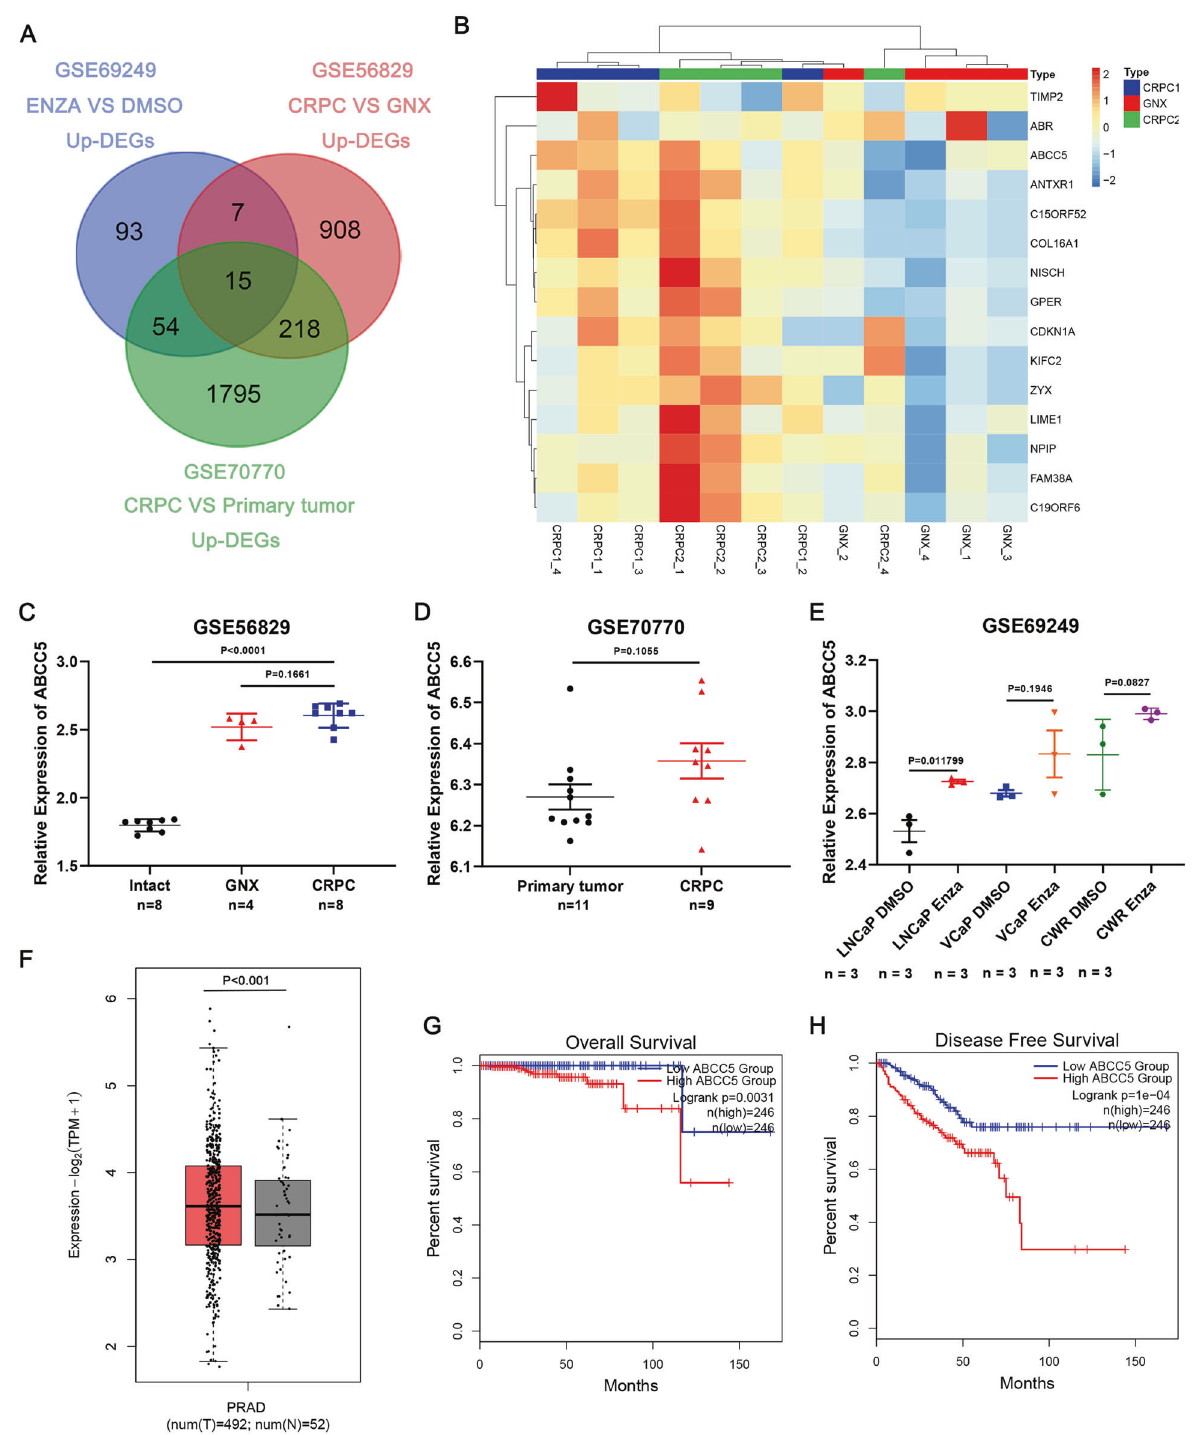
Fig. 1 ABCC5 expression is related to enzalutamide-resistance PCa and CRPC. A The Venn diagram gives the overlapped genes of high expression related to enzalutamide-resistance and CRPC among the three GEO datasets above, including GSE69249 (enzalutamide treated vs. DMSO vehicle-treated LNCaP, VCaP, and CWR cell lines, top 10% up-regulated, P < 0.05), GSE56829 (CRPC vs. GNX, top 50% up-regulated, P < 0.05) and GSE70770 (CRPC vs. primary tumor, top 50% up-regulated, P < 0.05). B The heatmap with unsupervised hierarchical clustering of 15 selected genes mRNA expression in the GSE56829 dataset. The red represents for higher expression and the blue represents for lower expression. The expression of ABCC5 and that in comparison among VCaP xenograft tumors collected at different times which de fi ned as intact, GNX, and CRPC groups in GSE56829 ( C ), and that of CRPC and primary tumor in the GSE70770 dataset ( D ) and that in comparison between enzalutamide treated and DMSO treated cells in GSE69249 ( E ). F The expression of ABCC5 in TCGA database, prostate tumor (Red) and normal (gray). Kaplan – Meier curves respectively for OS ( G ) and DFS ( H ), and of PCa patients with high versus low expression of ABCC5 in TCGA. * P < 0.05, and **** P < 0.0001.